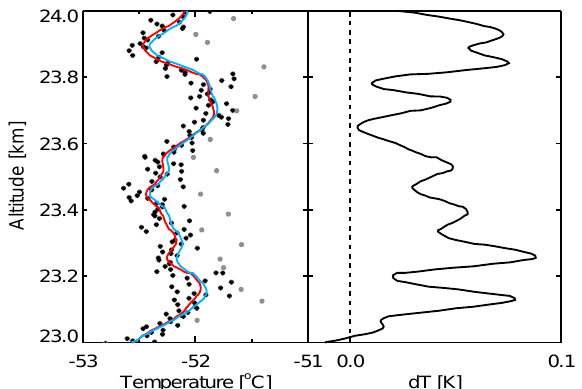
Figure 8. Left panel: temperature profile before (black dots) and Fig. 8. Left panel: temperature profile before (black dots) and after smoothing and consecutive spike removal after smoothing and consecutive spike removal (red trace). The (red trace). The grey dots represent the temperature spikes that were removed by the spike removal algorithm. grey dots represent the temperature spikes that were removed by The blue trace represent the smoothed profile before spike removal. The right panel shows the difference be- the spike-removal algorithm. The blue trace represent the smoothed tweentheblueandtheredcurves. ThesoundingwasperformedinLindenbergon16August2012(12:00UTC), profile before spike removal. The right panel shows the difference maximum solar zenith angle during the sounding: 48.9 ◦ . between the blue and the red curves. The sounding was performed in Lindenberg on 16 August 2012 (12:00UTC); maximum solar zenith angle during the sounding: 48.9 ◦